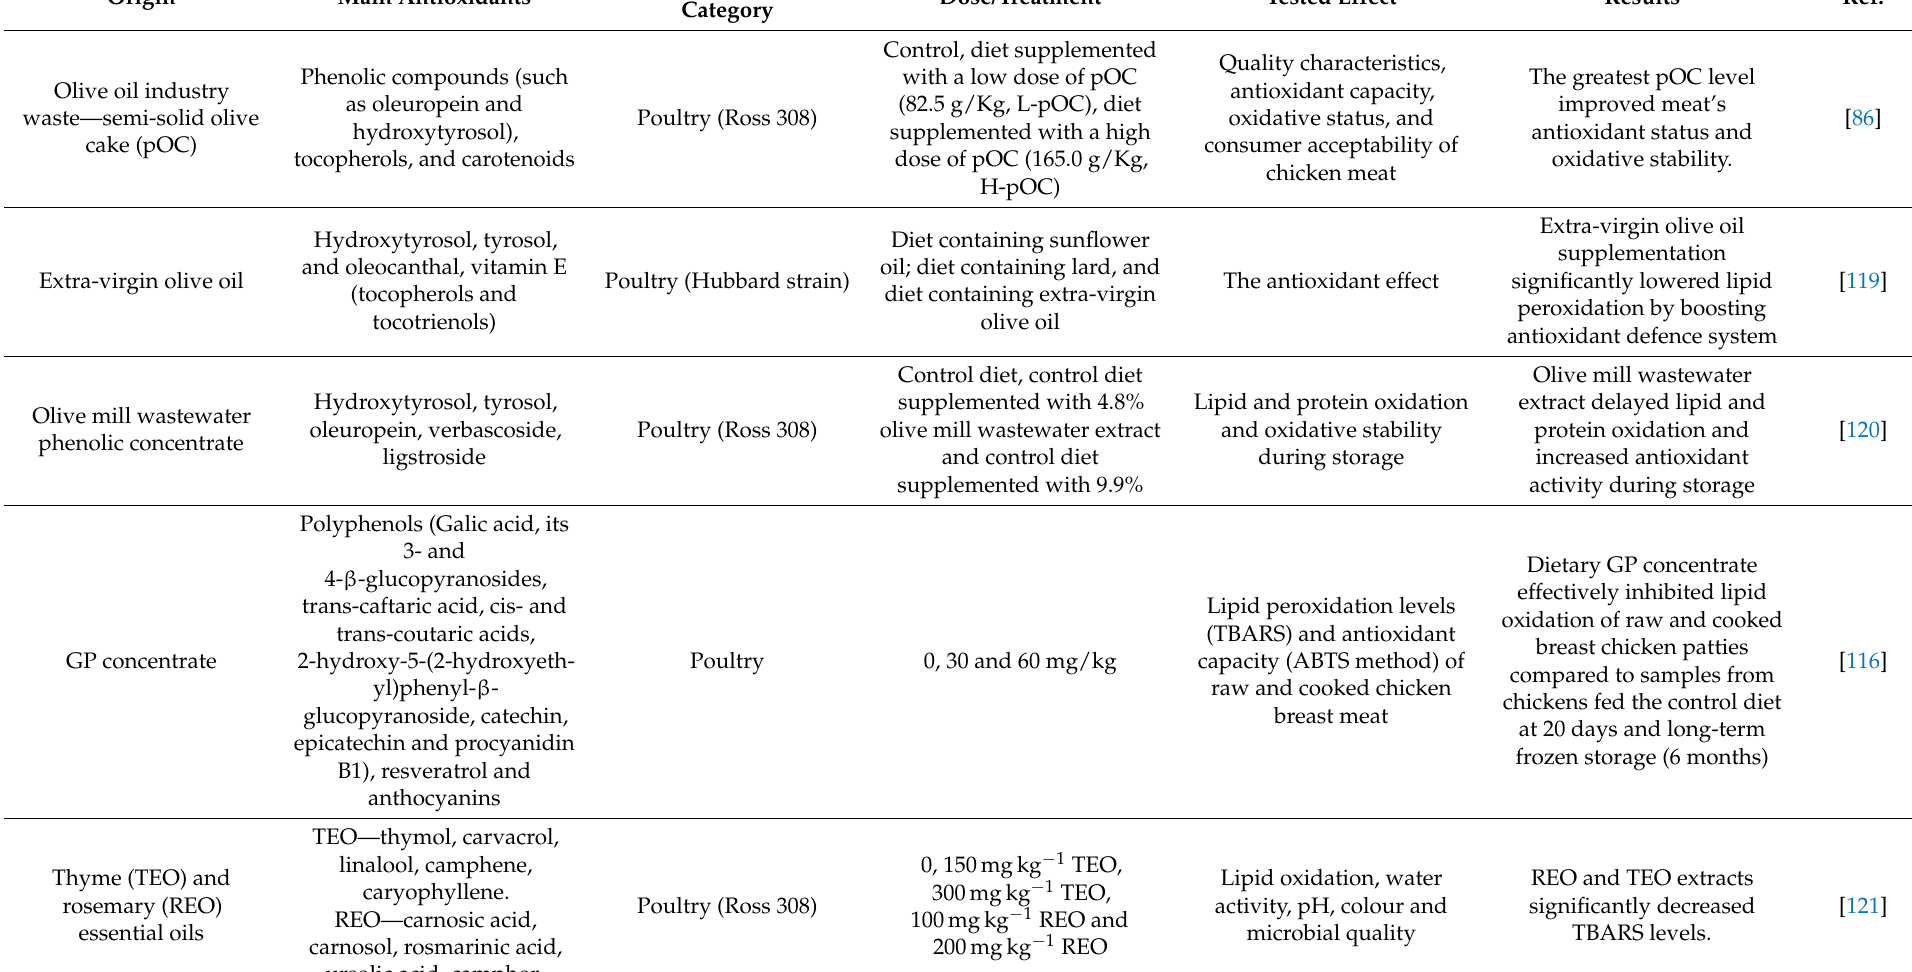
Table 5. Literature review on the effects of some natural antioxidant sources by diet supplementation in